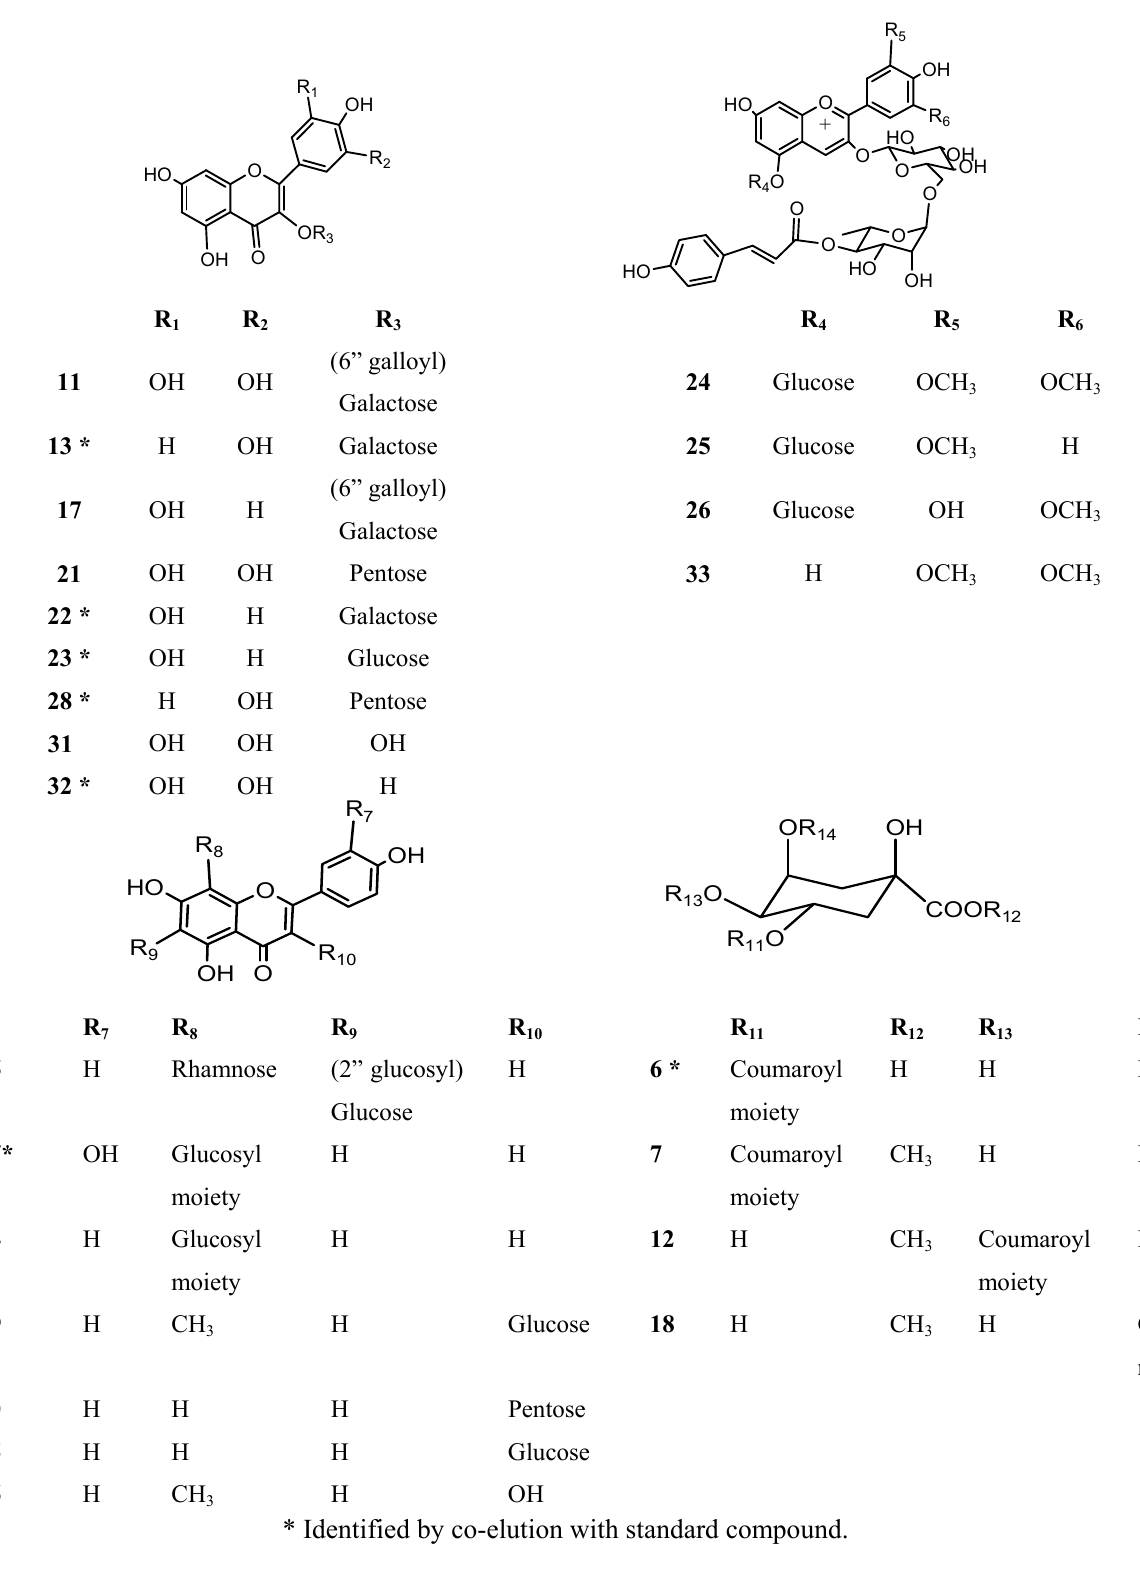
Figure 5. Proposed structures of flavonoids, anthocyanins and phenolic acids derivatives from peumo fruits identified by